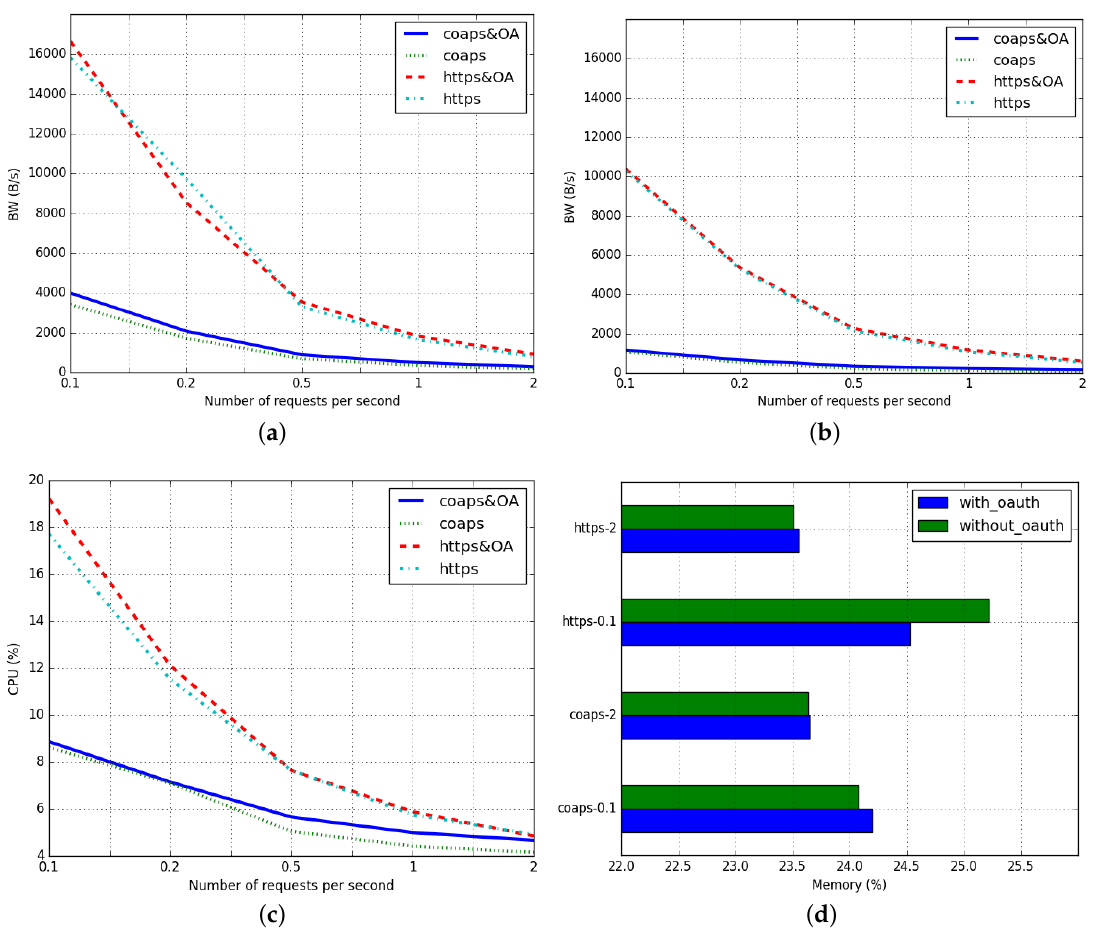
Figure 3. Bandwith, CPU and Memory performance. ( a ) Mean of BW sent; ( b ) Mean of BW recv; ( c ) Mean of CPU; ( d ) Mean of